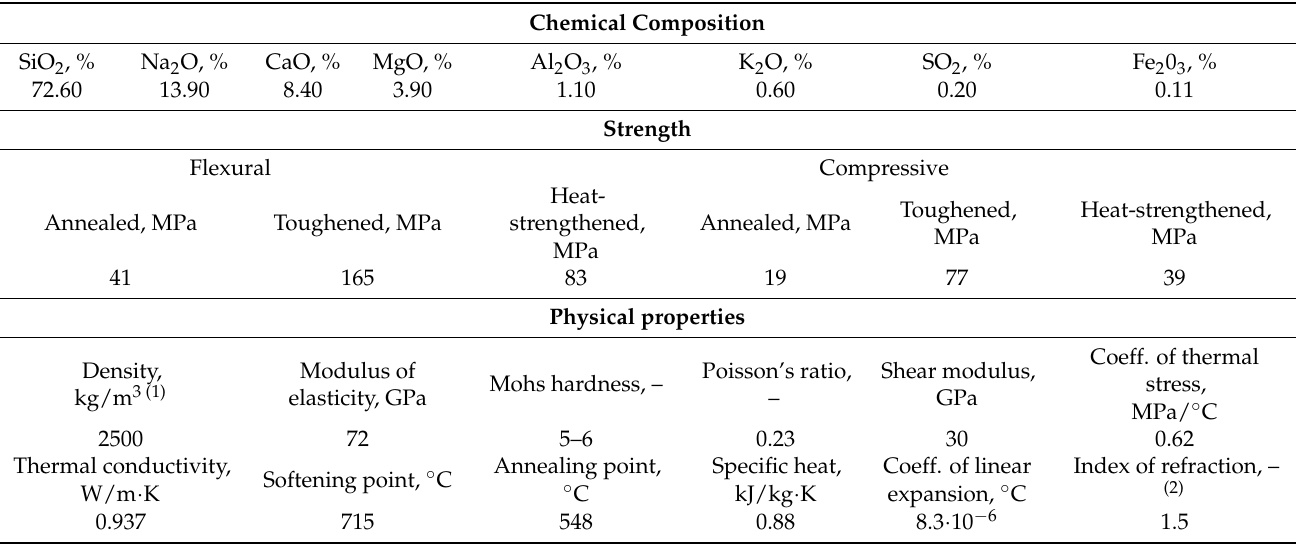
Table 2. General characteristics of soda-lime